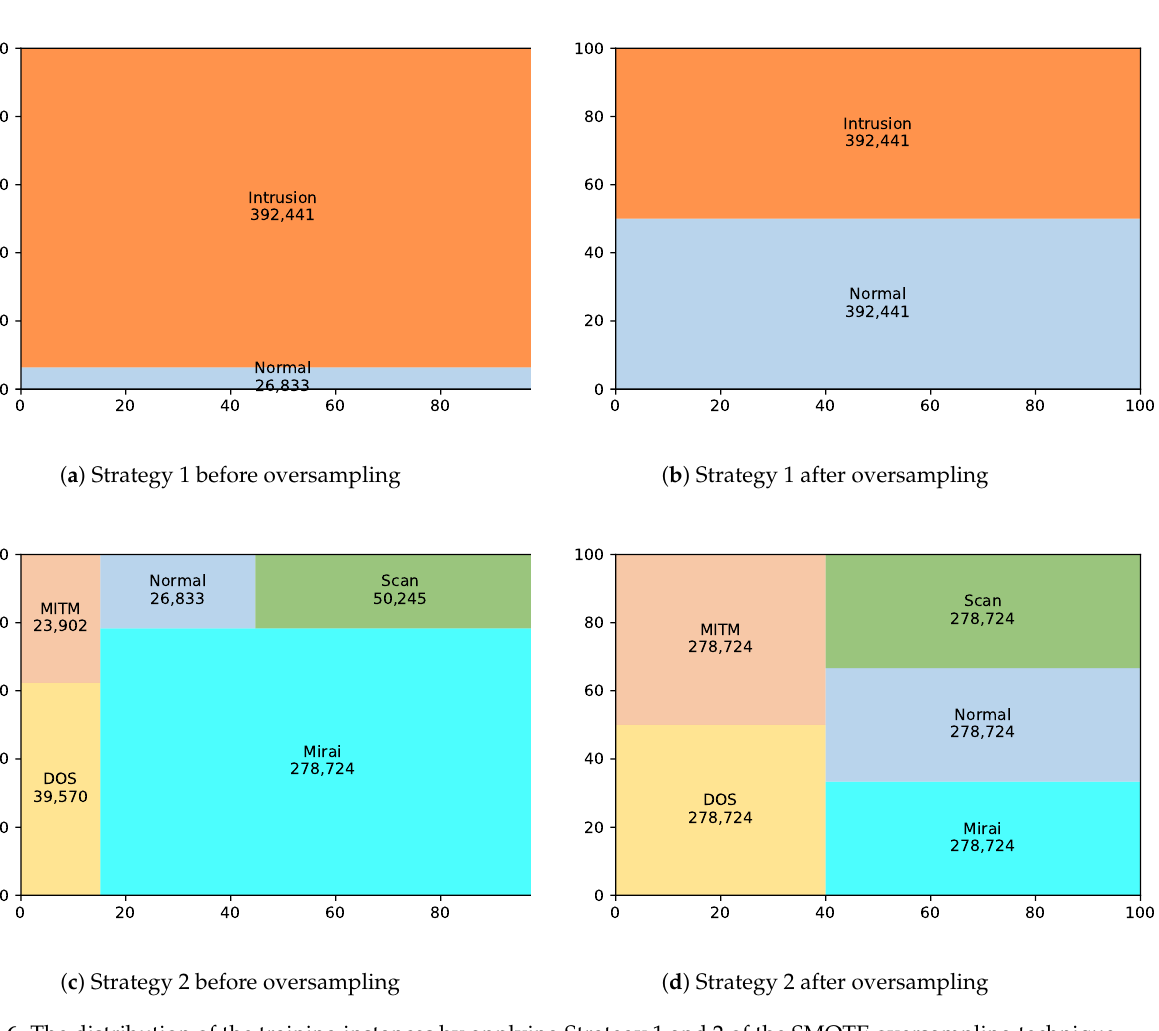
Figure 6. The distribution of the training instances by applying Strategy 1 and 2 of the SMOTE oversampling technique. Both strategies were tested on the IoTID20 dataset to find the best strategy for the approach proposed. The first strategy was tested using different values of the oversampling ratio values which are 0.2, 0.4, 0.6, 0.8, and 1. Figure 7 shows the results of applying the first strategy with the different values of the oversampling ratio for Accuracy, Recall, and G- mean measures. It is observed from the figure that the oversampling ratio of one is the best for G-mean and the Recall of the intrusion label, which is our main focus for IoT networks. Thus, we consider it for comparison with strategy